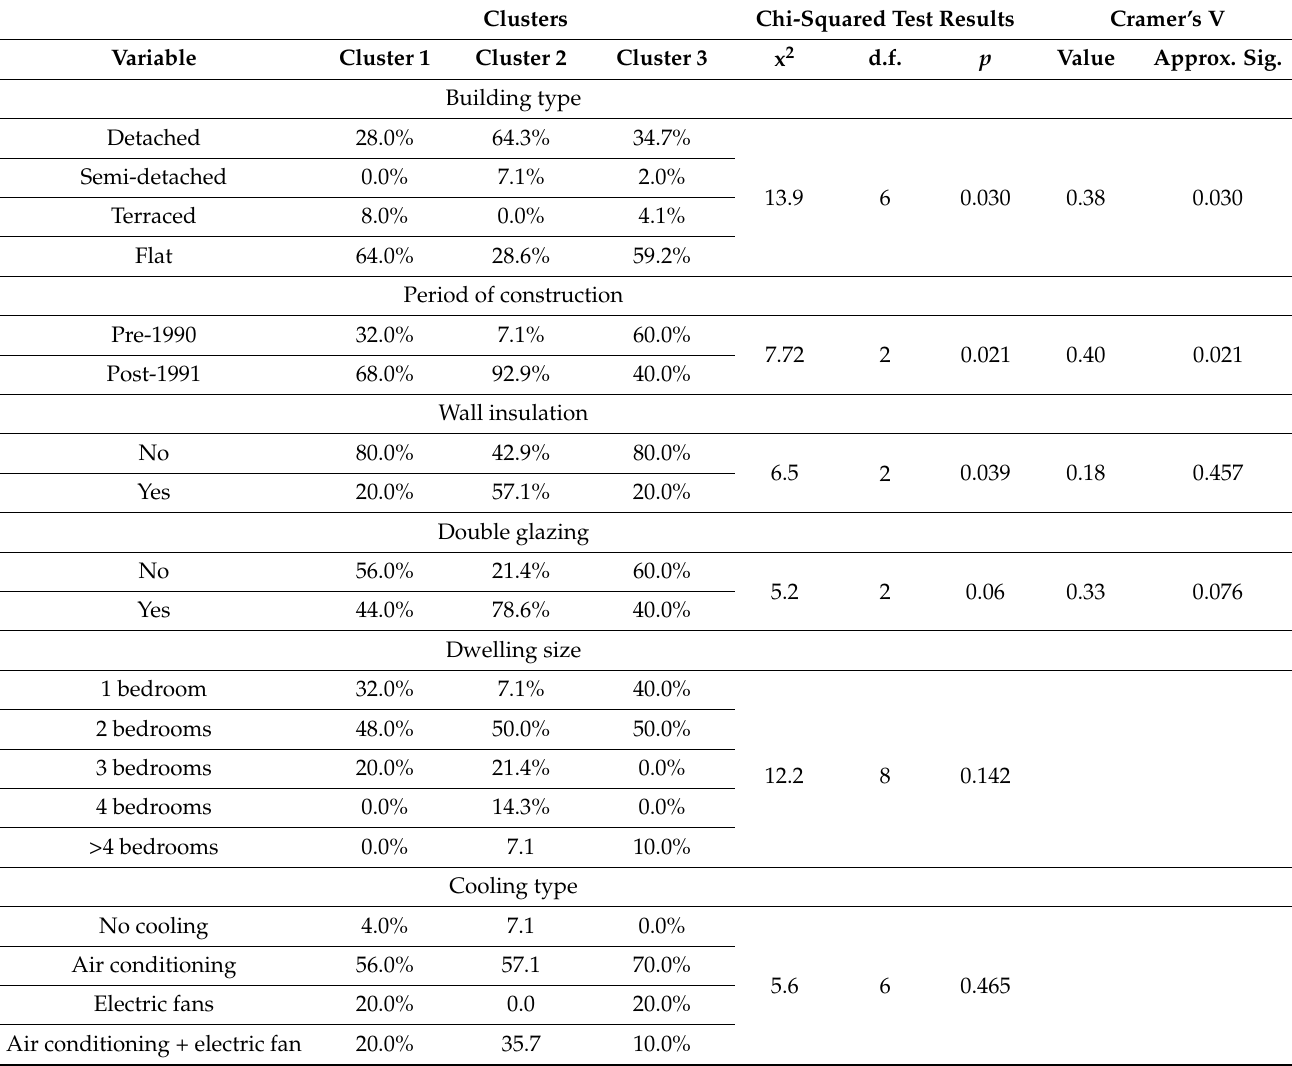
Table 4. Chi-squared analysis of building variables between clusters in